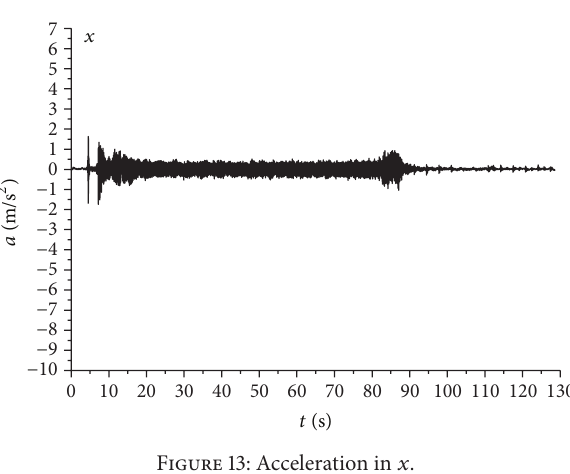
Figure 13: Acceleration in 𝑥 . Figure 14: Amplitude in 𝑥 .